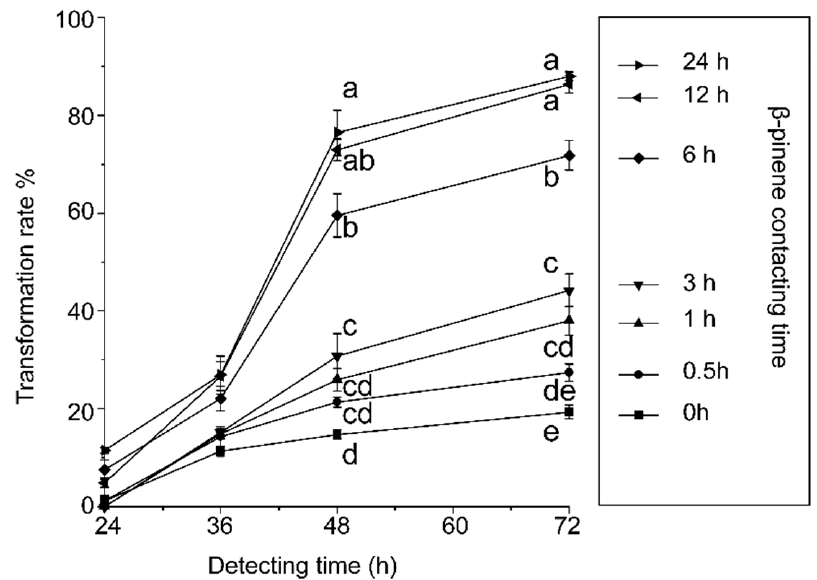
Figure 2. Transformation rate of B. xylophilus J IV promoted by β -pinene with different contacting times. Statistical differences in the means are indicated with different letters, p < 0.05. Error bars represent ± SE.